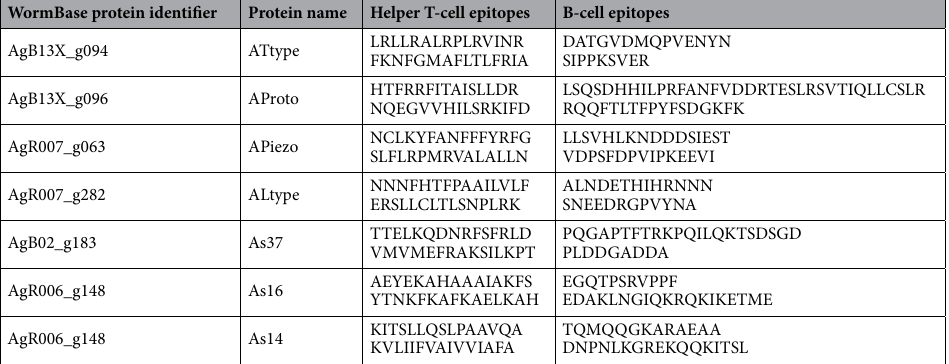
WormBase protein identifier Protein name Helper T-cell epitopes B-cell